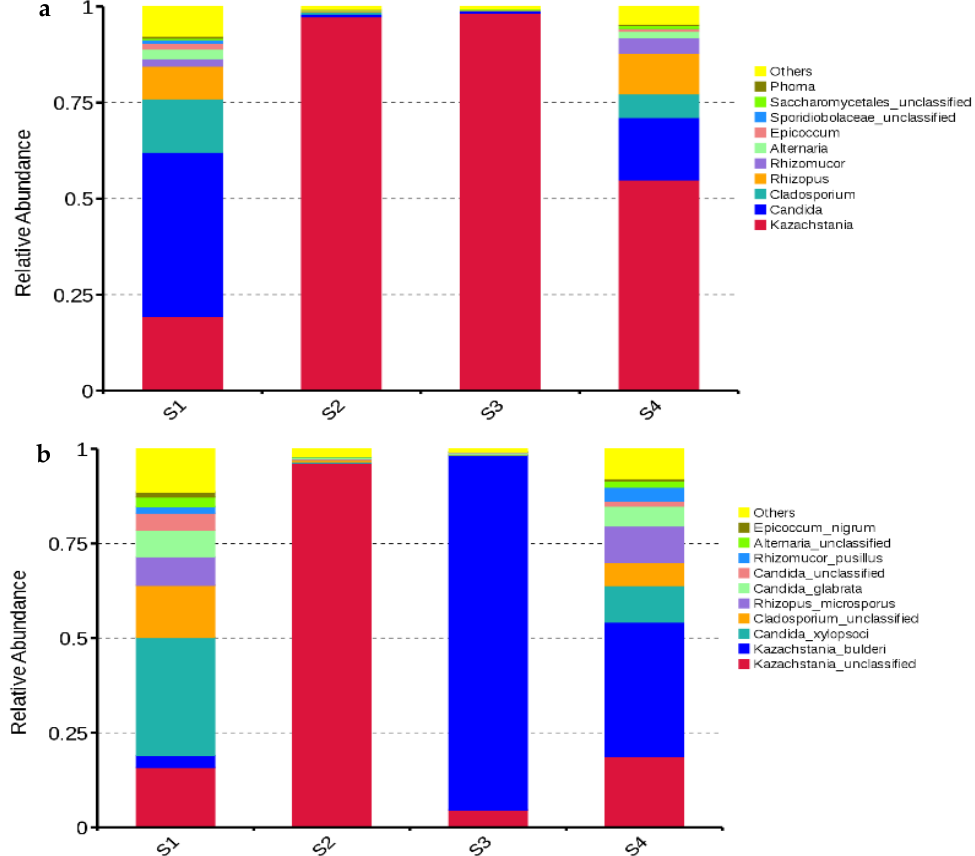
Figure 4. Relative abundances of fungal genera ( a ) and species ( b ) in whole-plant corn silage (n = 3). S1, silage collected from Erdos; S2, silage collected from Baotou; S3, silage collected from Ulanqab; S4, silage collected from Hohhot.